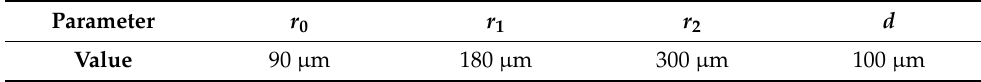
Table 1. Main parameters in the